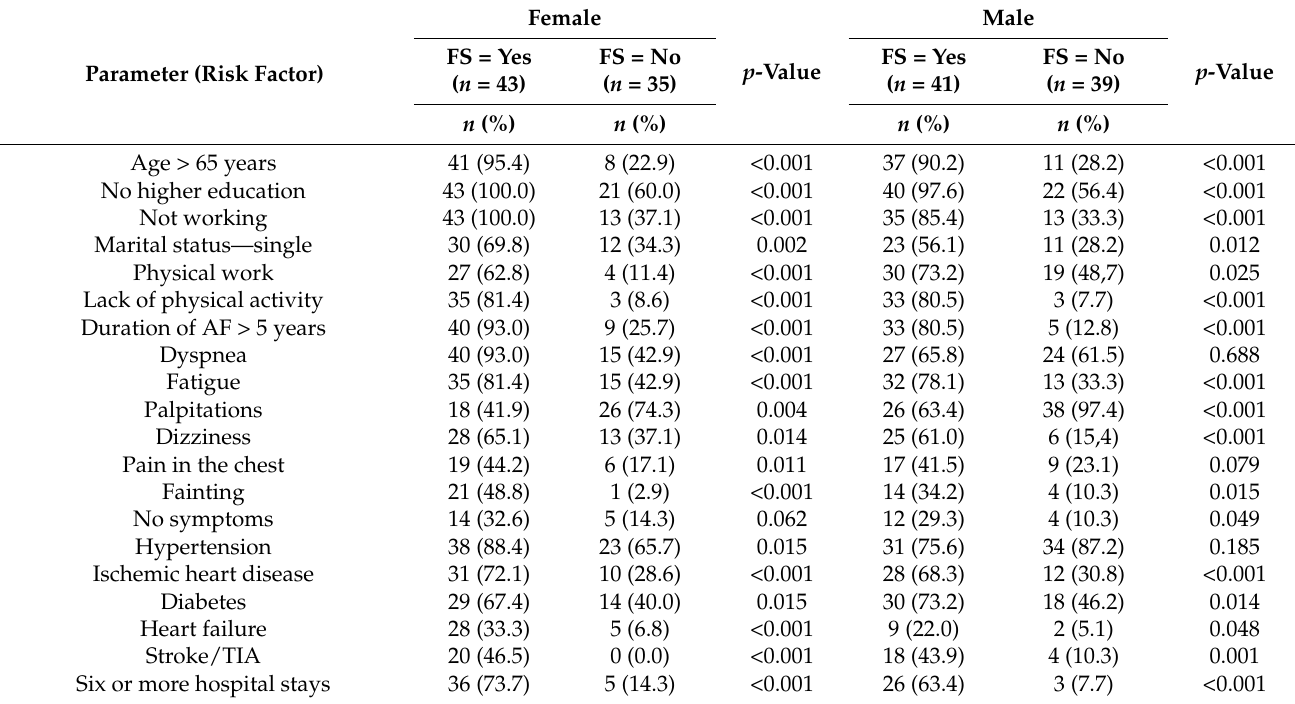
Table 5. Factors associated with frailty syndrome (FS) in patients with atrial fibrillation (AF) and chi-squared test results.